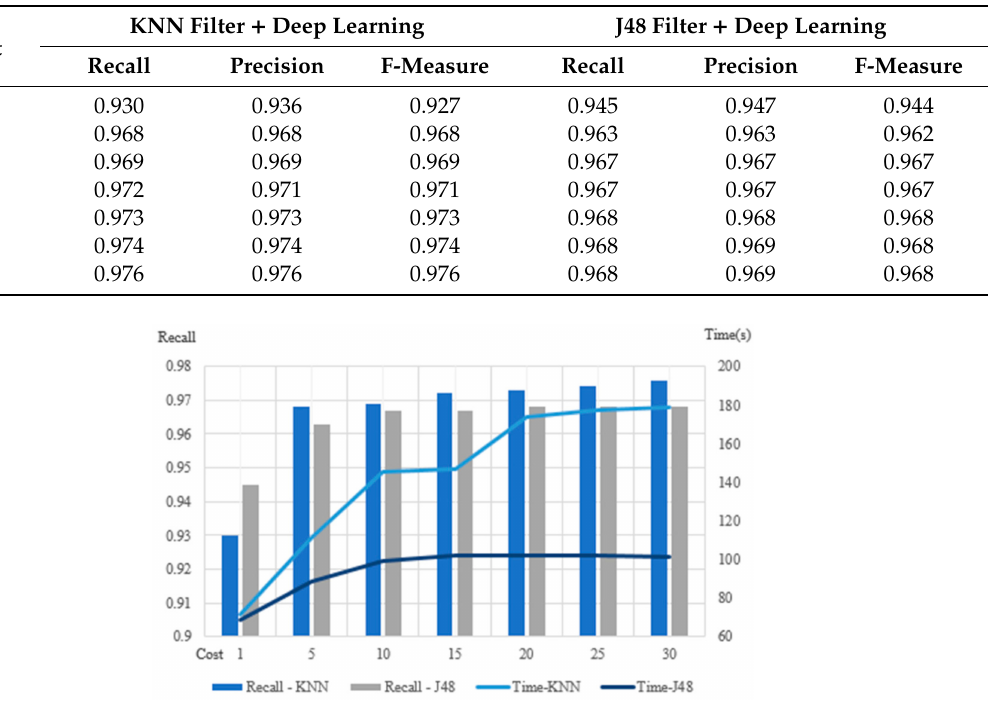
Table 6. Overall classification accuracy of the framework according to cost change.